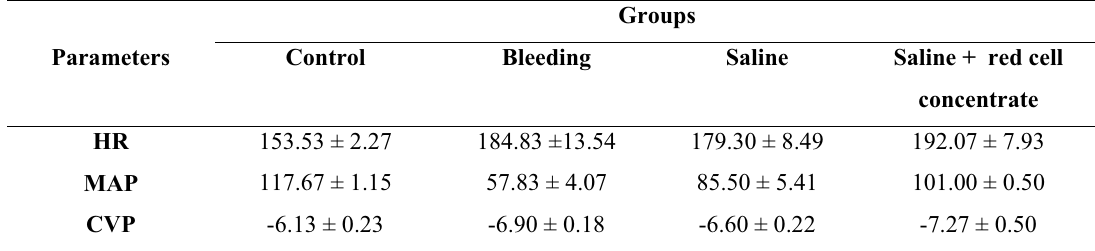
TABLE 1 - Mean values and standard deviations of HR, MAP and CVP obtained in the control, bleeding, saline and saline + red cell concentrate